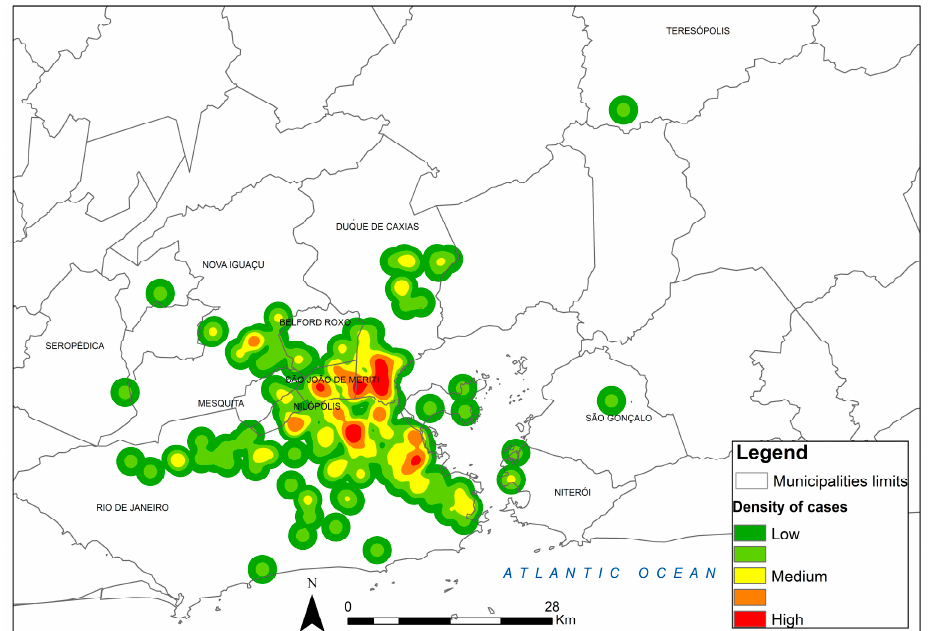
Figure 4. Kernel map of canine sporotrichosis cases in the state of Rio de Janeiro, Brazil, between 1998–2018. Source: Instituto Nacional de Infectologia Evandro Chagas/Fiocruz.